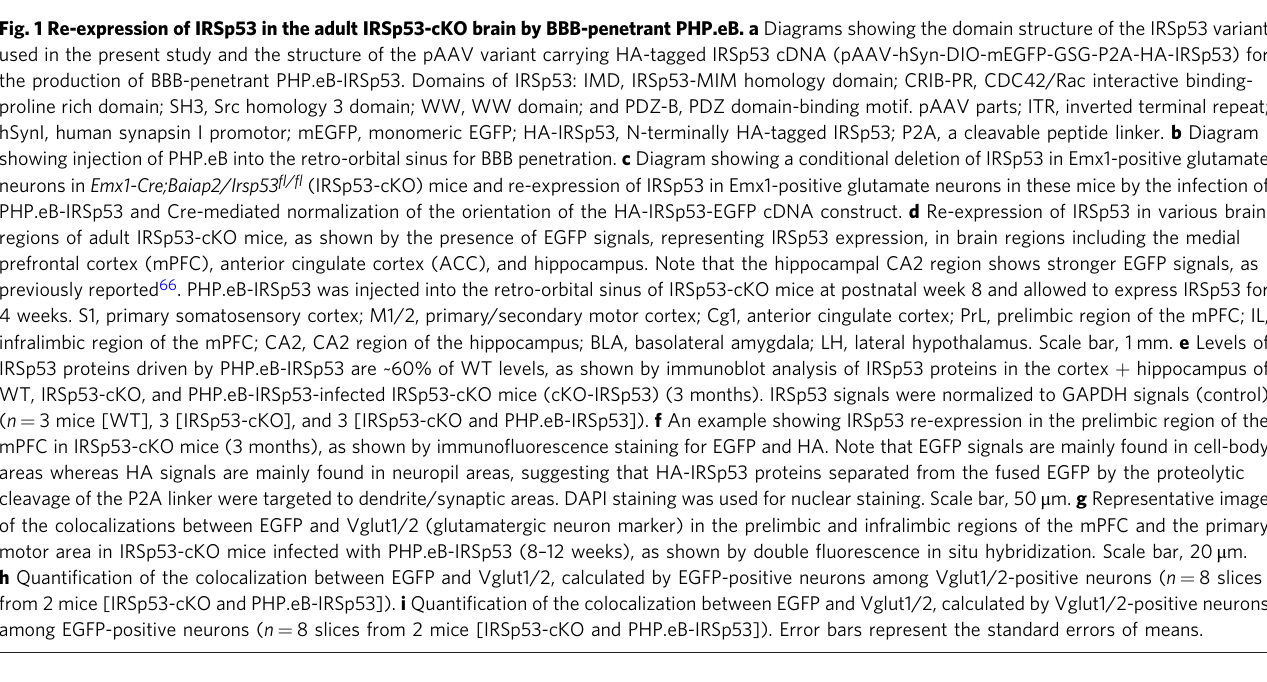
(Fig. 2e, f). However, the positive social novelty recognition in another IRSp53-cKO mouse line ( CaMKII α -Cre;Baiap2 fl / fl mice; may stem from the distinct natures of the two cKO mouse lines (i.e., different cell-type-speci fi c cKOs of the same gene). These